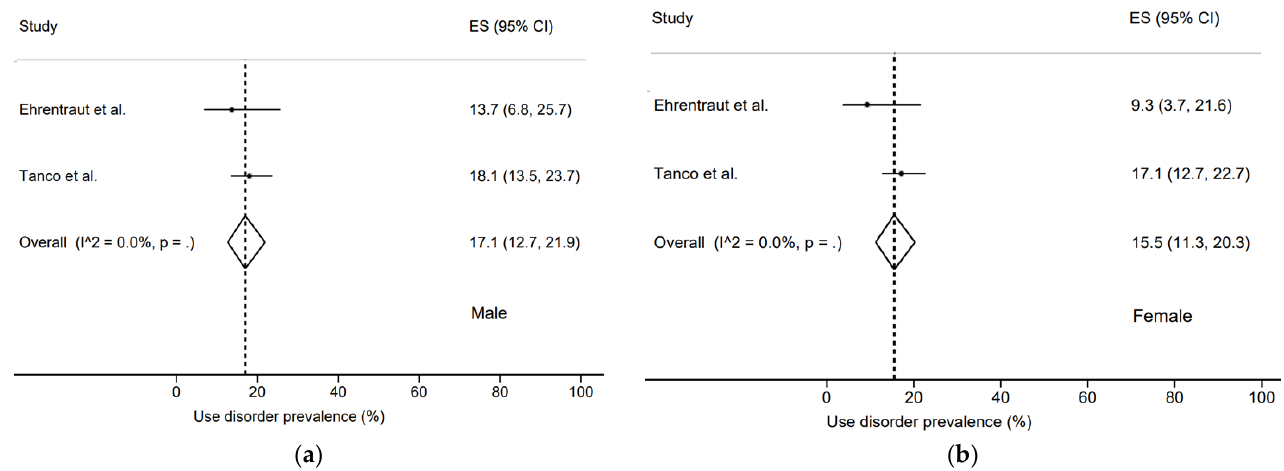
Figure 5. Use disorder prevalence by sex: ( a ) Male; ( b ) Female [20,22].